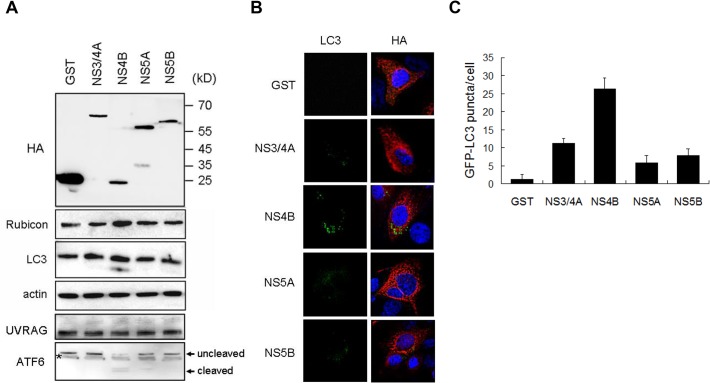
Effects of HCV nonstructural proteins on the induction of Rubicon and autophagosomes.(A) Western-blot analysis of Huh7 cells transfected with the expression plasmids of HA-tagged GST and various HCV nonstructural proteins. Cells were lysed 48 hours after transfection for analysis. The localizations of molecular weight markers are indicated. The asterisk denotes a nonspecific protein band. (B) Analysis of GFP-LC3 puncta in stable Huh7 cells that expressed GFP-LC3. Cells were transfected with various expression plasmids for 48 hours and immunostained with the anti-HA antibody (red color). GFP-LC3 puncta were apparent in cells that expressed HCV NS4B. (C) The average number of GFP-LC3 puncta per cell shown in (B). The results represent the mean of >30 cells.